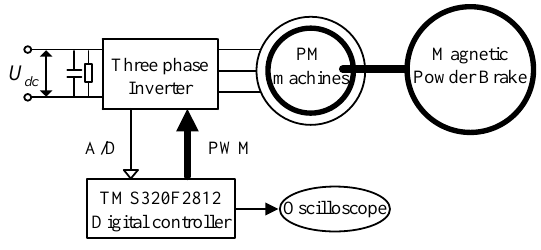
Figure 16. The diagram of test bench.